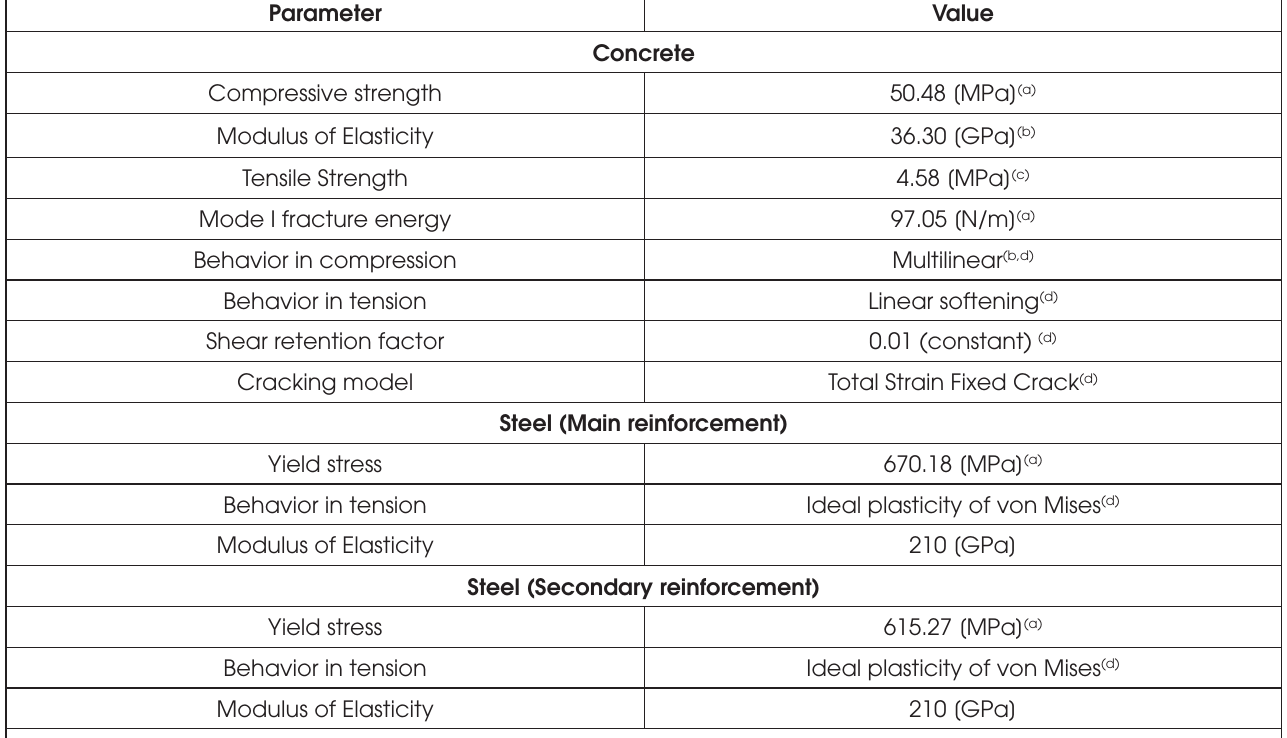
Parameters used in computational modeling